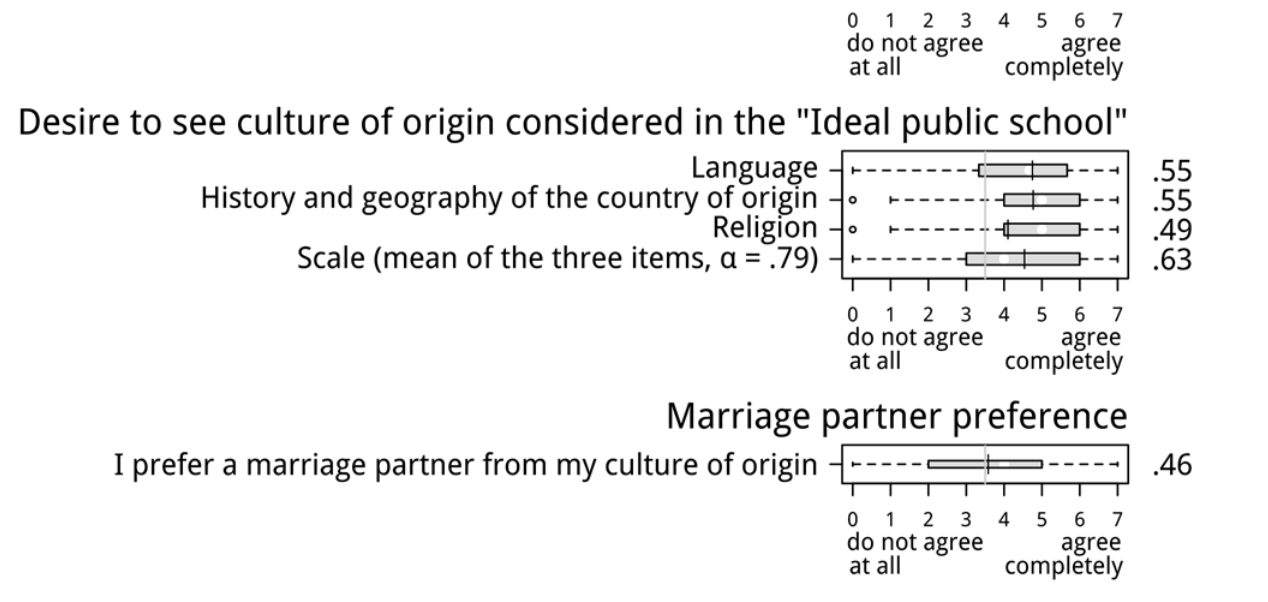
Fig 3. Effects of the culture-transmission motive on action tendencies and desires supportive of cultural transmission. Shown are boxplots of the distributions of the corresponding items. The median is represented by a white circle and the mean by a black bar; the box ranges from the first to the third quartile. The correlation of each item to the culture-transmission motive is listed next to the item on the right side of the figure. All correlations are significant at p < . 001.